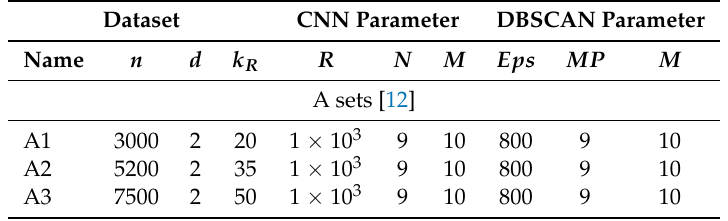
Figure 2. Performance of the common nearest neighbor (CNN) algorithm on a variety of different two-dimensional (2D) datasets; the parameter sets are presented in Table 1; non-assigned data points (noise) are highlighted in light gray; if accessible, the true centroids are highlighted blue. A For the Birch3 dataset, a three-step hierarchical clustering approach was applied. The original clusters after the first step are highlighted in light red and light blue. Table 1. Properties of the benchmark datasets: n : dataset size; d : dimensionality; k R : reference number of clusters. Parameters for the common nearest neighbor (CNN) algorithm: R and N : cluster parameter set; M : minimal cluster size. Parameter for the Density based spatial clustering of applications with noise DBSCAN algorithm: Eps : cutoff distance; MP : minimum number of neighbors; M : minimal cluster size. A Hierarchical clustering was necessary. B The size was reduced from 100,000 extracting every 10th data